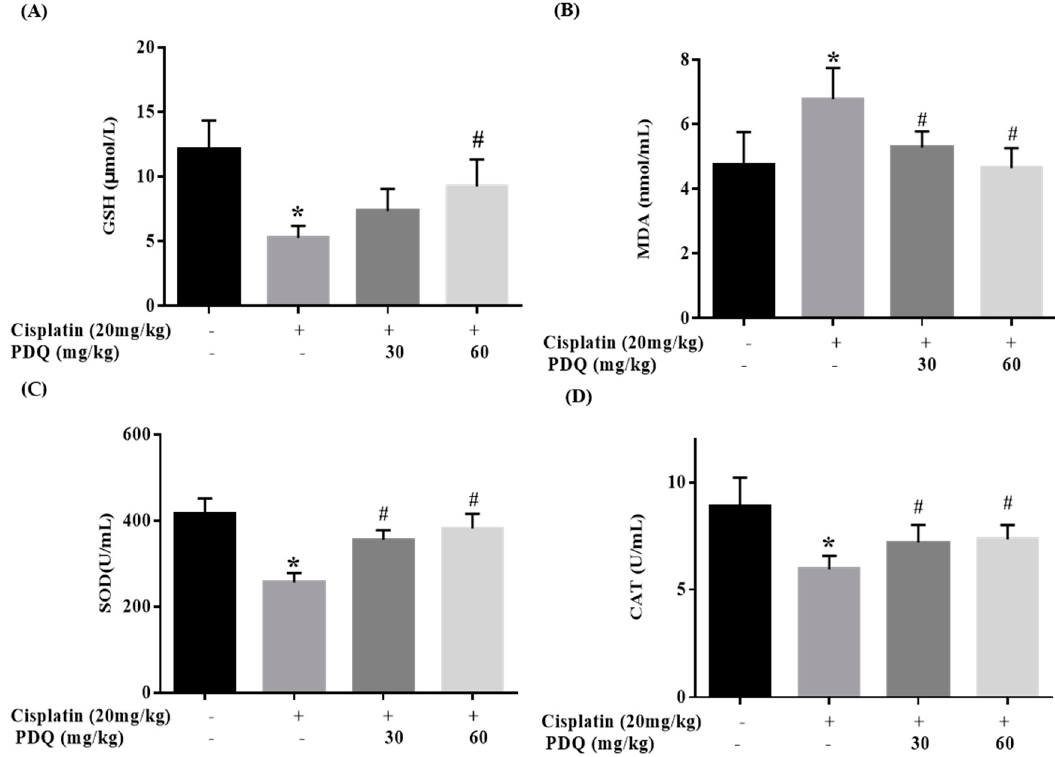
Figure 5. Effects of PDQ on the levels of glutathione (GSH) ( A ), malondialdehyde (MDA) ( B ), superoxide dismutase (SOD) ( C ), and catalase (CAT) ( D ) in cisplatin-induced acute kidney injury (AKI). All data are expressed as the mean ± S.D., n = 8. * p < 0.05 vs. control group; # p < 0.05 vs. cisplatin group.